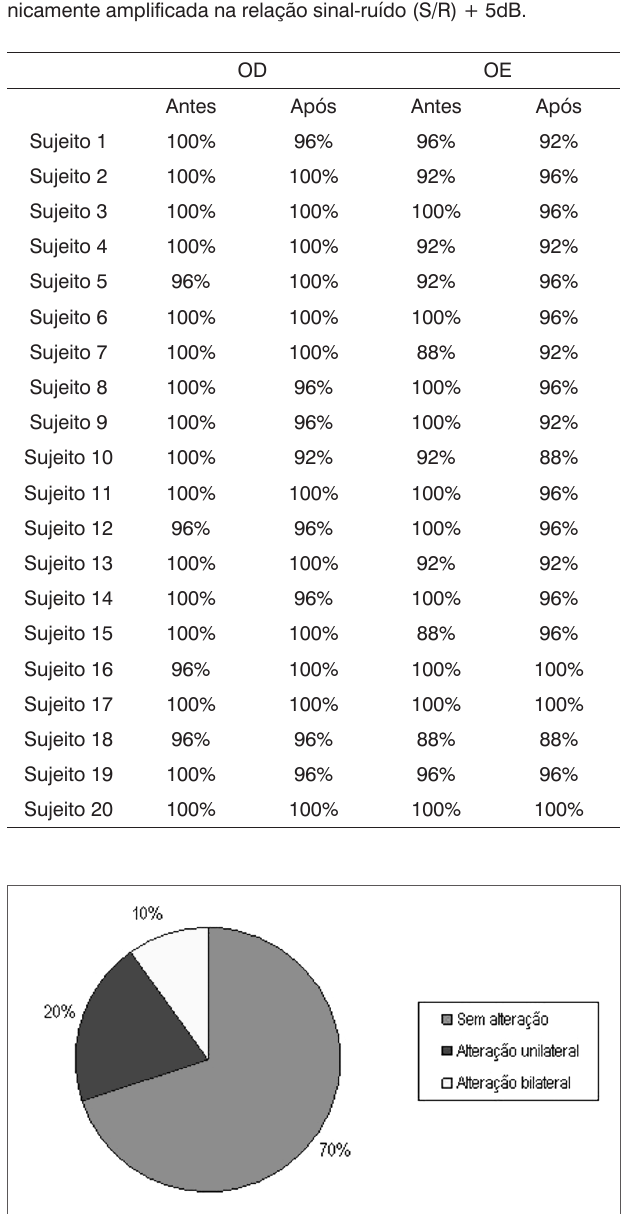
Figura 2. Porcentagem de alterações no IPRF, ocorridas após a ex- posição à música na relação S/R + 5